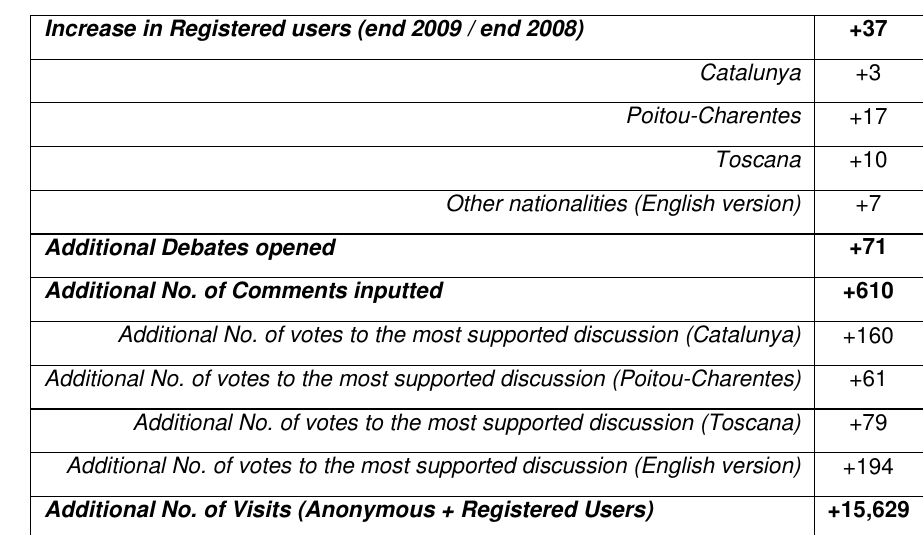
Table 2: SNP Indicators (January-December 2009)